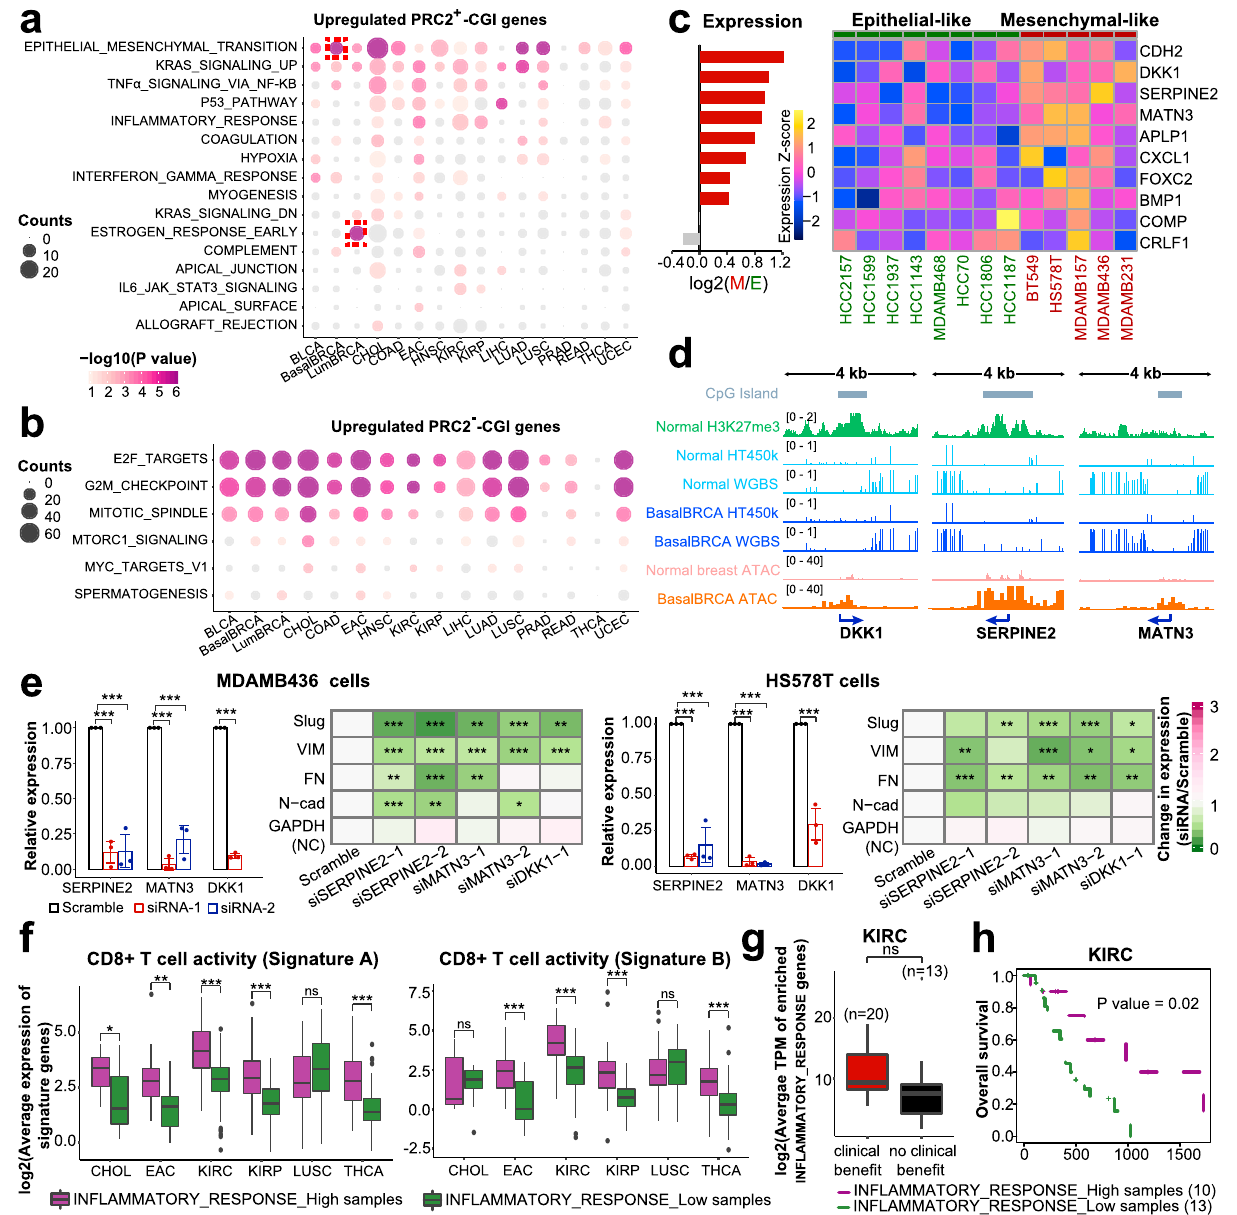
Fig. 4 Upregulated PRC2 + - and PRC2 − – CGI genes control distinct sets of biological pathways in cancer. a , b Hallmark pathway enrichment results for ( a ) upregulated PRC2 + -CGI genes and ( b ) upregulated PRC2 − -CGI genes. “ EMT ” and “ Estrogen response early ” are highlighted in the two breast cancer subtypes. For a , b the one-sided binomial-test was performed on these two groups and the enriched hallmarks with unadjusted p -value < 0.05 were identi fi ed. c Expression of the 10 BasalBRCA upregulated PRC2 + -CGI genes in the EMT pathway are shown in 13 BasalBRCA cell lines annotated by an established consensus EMT classi fi cation (see text). d IGV plots for the top 3 EMT genes from panel c . e siRNA loss-of-function assays for the top three genes followed by expression measurement of established mesenchymal markers. n = 3 biologically independent experiments. Data are presented as mean ± SD. p -values were determined by a one-sided t -test. p < 0.001***; p < 0.01**; p < 0.05*. The exact p -values are shown in Supplementary Data 4. f Average expression of CD8 + T-cell signature genes in the six cancer types enriched in the in fl ammatory response pathway from panel a , showing the top and bottom 20% of tumors based on the average expression of upregulated PRC2 + -CGI genes in the in fl ammatory response pathway. Signature A contains CCL2 , CCL3 , CCL4 , CXCL9 , CXCL10 , CD8A , HLA-DOB , HLA-DMB , HLA-DOA , GZMK , ICOS and IRF1 36 . Signature B contains GZMA and PRF1 37 . p -values were determined by a one-sided t -test. p < 0.001***; p < 0.01**; p < 0.05*; p > 0.05, ns. The exact p -values are shown in Supplementary Data 4. Expression datasets were obtained from TCGA. We only showed cancer types where the pathways were enriched with a p -value < 0.05. The total tumor sample sizes with expression data in different cancer types are listed in Supplementary Table 1 and the top and bottom 20% of tumor samples in each cancer type were used. g The average expression of upregulated PRC2 + -CGI genes in the in fl ammatory response pathway in KIRC patients with differential response to immune checkpoint therapies. Expression datasets are obtained from Miao et al. 38 . p -value was determined by a one-sided t -test. Box plots in ( f , g ) indicate the median (middle line), 25th, 75th percentile (box) and 5th and 95th percentile (whiskers). h Kaplan – Meier survival plot analyzing the average expression of upregulated PRC2 + -CGI genes in in fl ammatory response pathway using the same cohort of KIRC